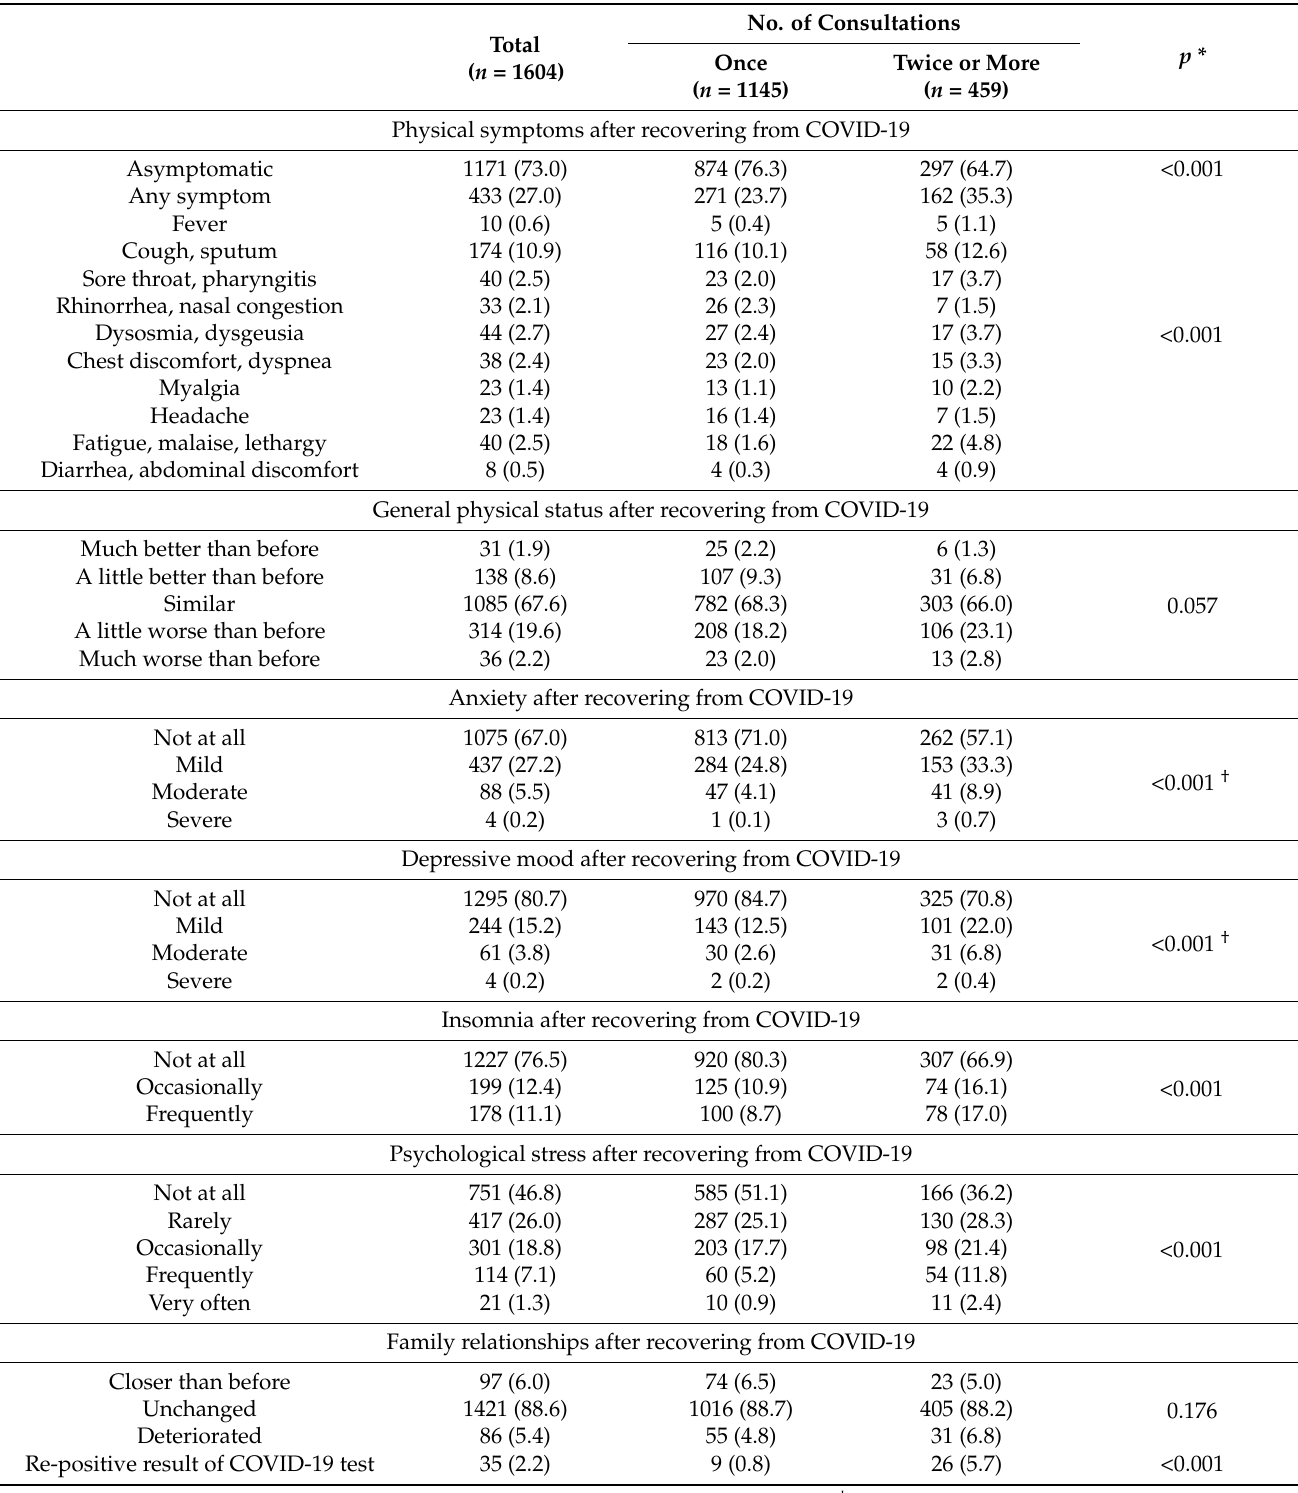
Table 2. Physical and psychological status after recovery from